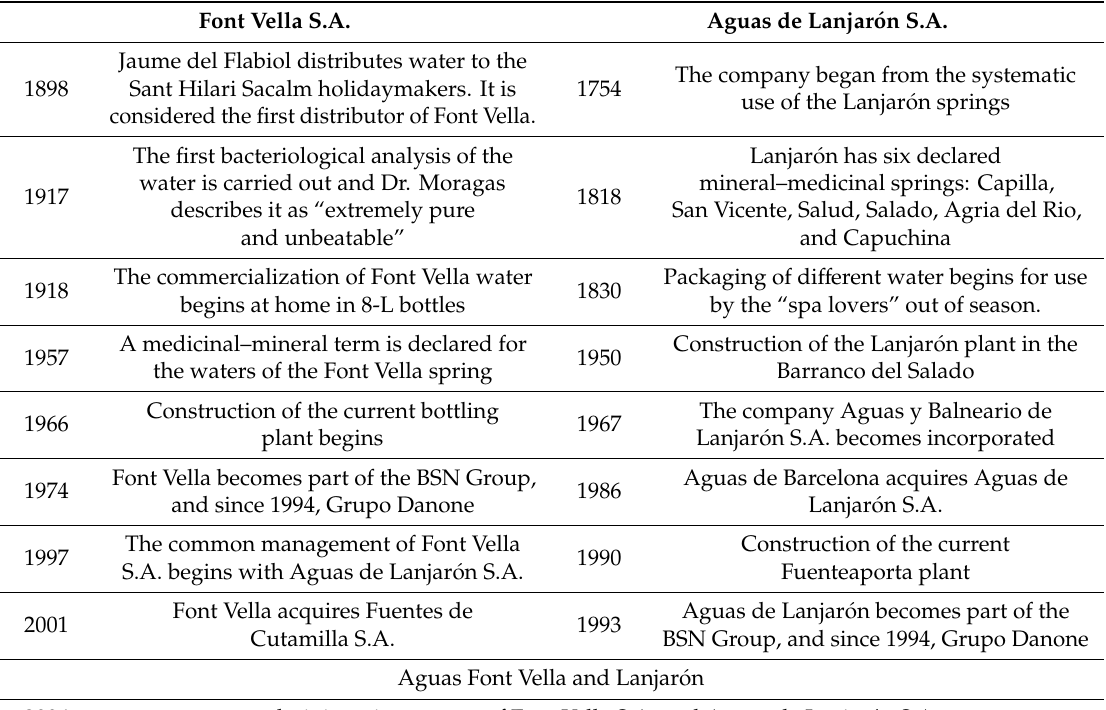
Table 6. Main milestones of Aguas de Font Vella and Aguas de Lanjar ó n. Source: Aguas Font Vella y Lanjar ó n S.A. (2006), Press Kit 2015: https: // corporate.danone.es / es / conecta / prensa / publicaciones /